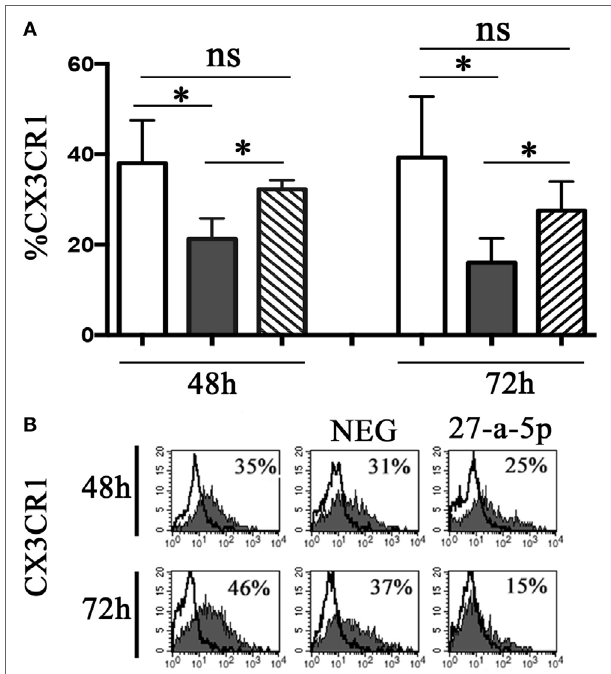
FigUre 5 | miR-27a-5p-induced downregulation of CX 3 CR1 surface expression. (a) CX 3 CR1 + HEK293T cells (clone #124) untrasfected (white bar), transfected with miR-27a-5p mimic (black bar), or miRNA negative control (stripped bar) were analyzed by flow cytometry for the expression of CX 3 CR1 at the indicated time intervals. Average of four independent experiments. 95% confidence intervals and significance (* p < 0.05) are shown. ns, non-significant. (B) Representative cytofluorimetric analysis of CX 3 CR1 surface expression. Values inside each histogram indicate the percentage (%) of positive cells. NEG: miRNA negative